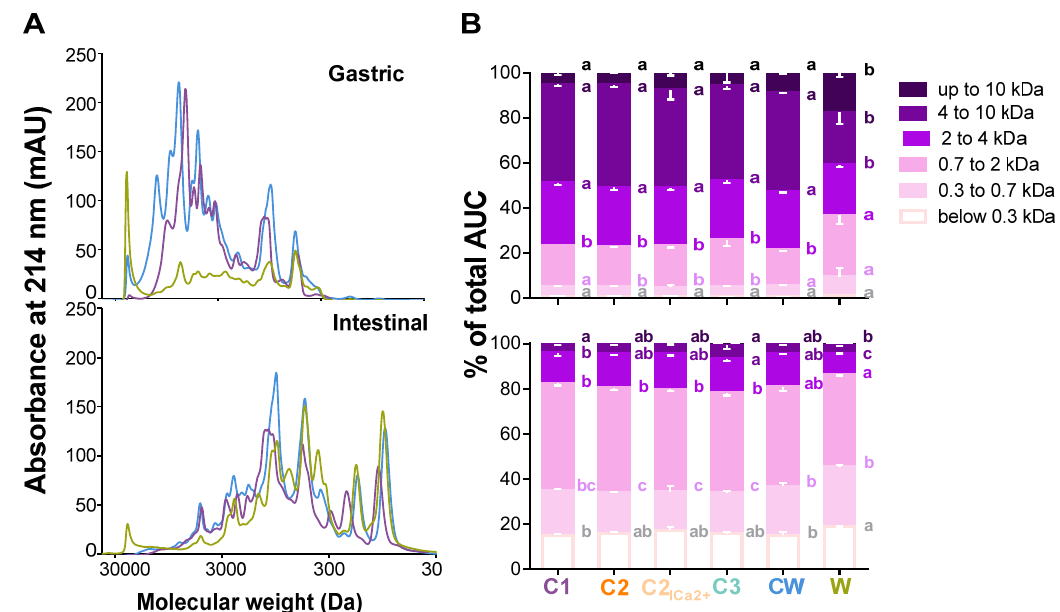
Figure 3. Molecular weight profiles and distributions of the gastric and intestinal digests of the di ff erent matrices: ( A ) peptide profiles were obtained by size-exclusion chromatography-fast protein liquid chromatography (SEC-FPLC): W (green curve), CW (dark blue curve), C1 (purple curve), 2-h gastric digests (top), and 2-h intestinal digests (bottom). ( B ) The mean ( ± SD) molecular weight distribution of peptides in the di ff erent compartment of the SGID, expressed in percentage of total area under the curve (AUC), was calculated from the linear regression relationship which correlates the Log of known molecular weight standard peptides and the elution volume. In a same molecular weight range, bars with di ff erent lowercase letters are significantly di ff erent ( p < 0.05, one-way ANOVA).